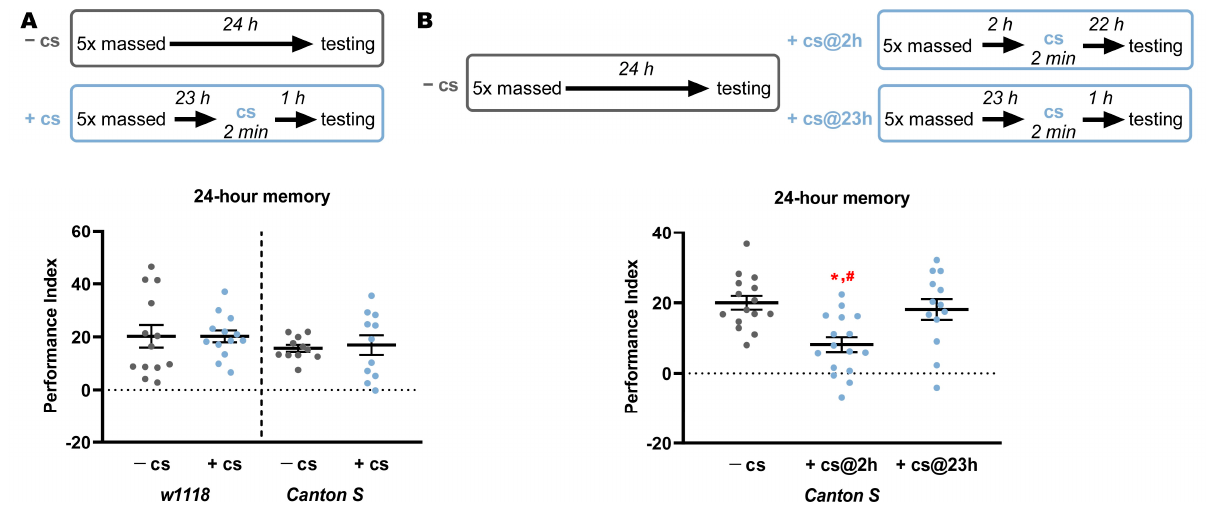
Figure 2. Memory acquired by massed training is resistant to cold shock at 23 h. Graphs show mean performance ± SEM consequent to the treatments detailed above. Star and pound symbols indicate significant differences as detailed below. ( A ) The 24-h memory elicited by MC is not affected by cold shock delivered 23 h post-training. Because variances were different, the unpaired parametric Welch’s t - test was used to compare means. ( t = 0.0039, df = 18.23, n = 13. p = 0.9969 for w 1118 and t = 0.3129, df = 12.50, n = 11. p = 0.7595 for Canton S ). ( B ) The 24-h memory elicited by MC is compromised if animals are cold shocked 2 h post-training, but not if cold shock is delivered 1 h before testing. [ANOVA F (2,44) = 7.992, p = 0.001. Subsequent comparisons using LSM-planned animals cold-shocked 2 h post-training ( p = 0.0006, star) and from those cold-shocked at 23 h ( p =